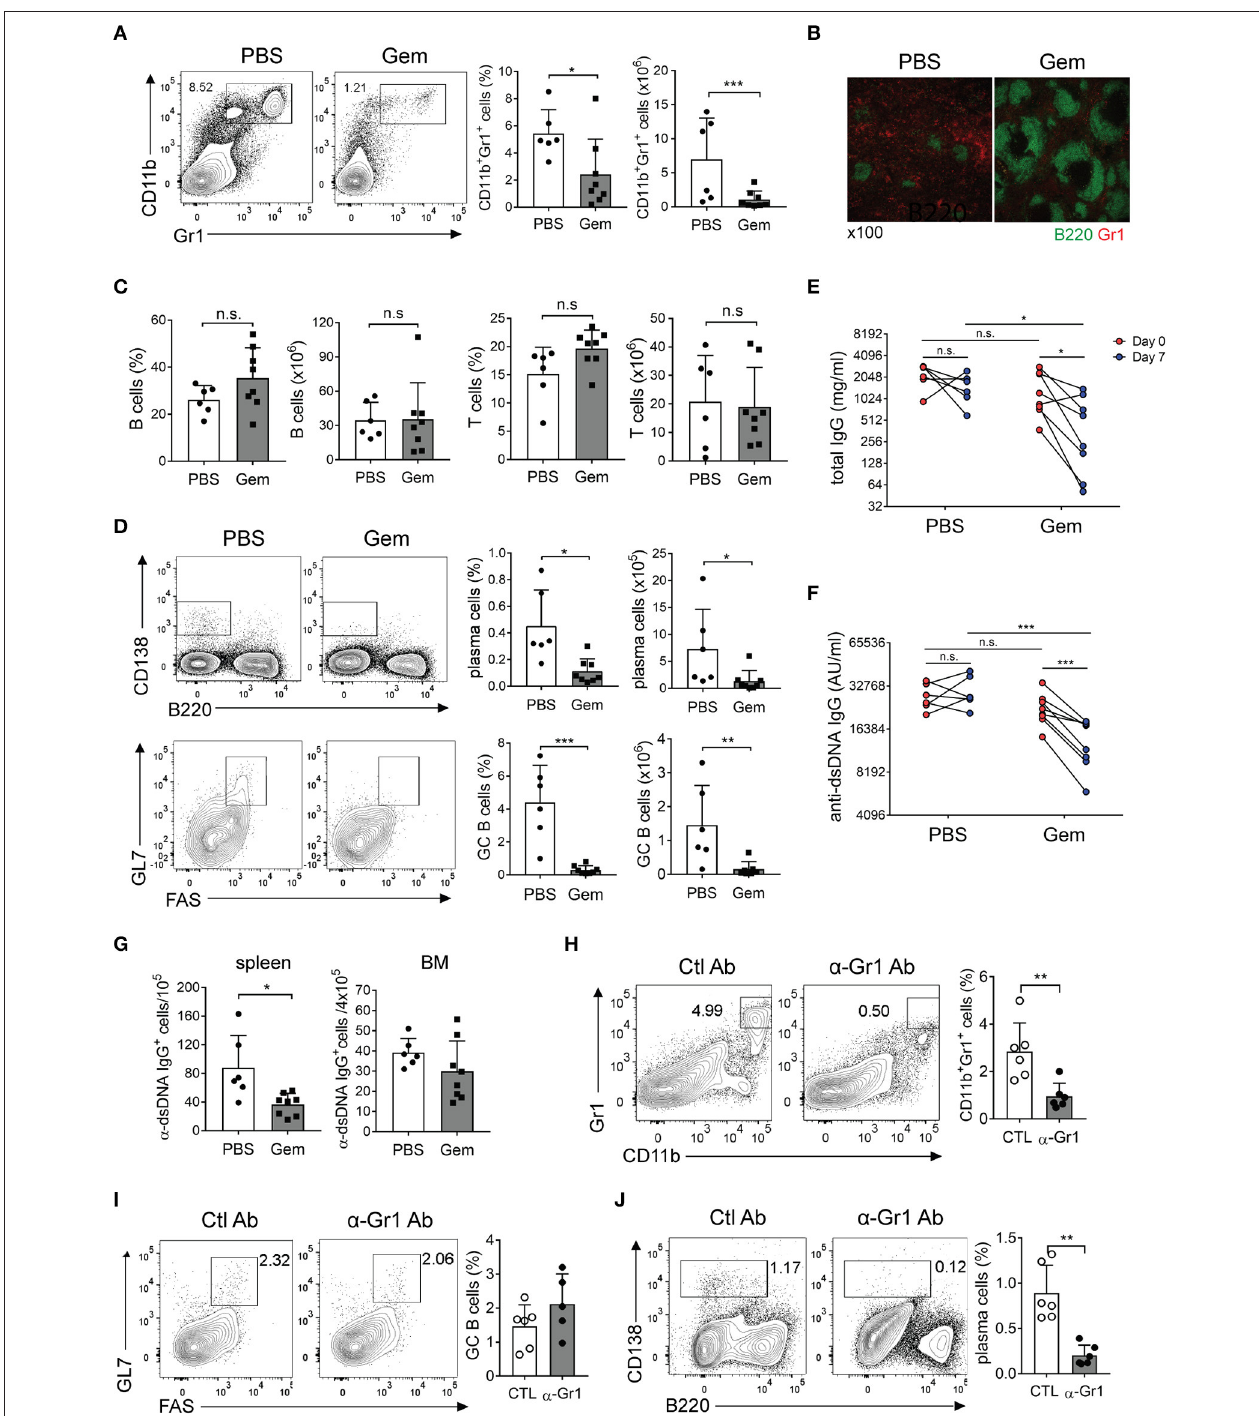
FIGURE 7 | The effect of Gr-1 + cell depletion on humoral autoimmunity. (A–G) Sanroque mice were injected with gemcitabine (Gem) or PBS and assayed post-mortem . (A) Representative FACS profiles and plots displaying percentages and numbers of Gr-1 + cells are shown. (B) Spleen sections were examined by fluorescence confocal microscopy. Original magnification, × 100. (C) Percentages and absolute numbers of splenic B and T cells. (D) Representative FACS profiles with percentages of PCs (B220 − CD138 + ) among total splenocytes, and GC B cells (GL7 + FAS + ) among B cells, are shown. (E,F) Sera collected on days 0 and 7 were analyzed by ELISA to measure levels of total and anti-dsDNA IgG Abs. (G) Splenocytes and BM cells were assayed by ELISPOT to determine numbers of anti-dsDNA-specific IgG Ab-secreting cells. (H–J) Disease-induced SKG mice were injected with anti-Gr-1 Ab or isotype-matched control Ab for 4 weeks and assayed by FACS. Representative FACS profiles with percentages of indicated cells are shown. Data are pooled from 2 repeat experiments and displayed as means ± SDs with symbols indicating individual mice. * p < 0.05, ** p < 0.01, and *** p < 0.001 by paired (E,F) or unpaired (the others) Student’s t -tests. San, sanroque.